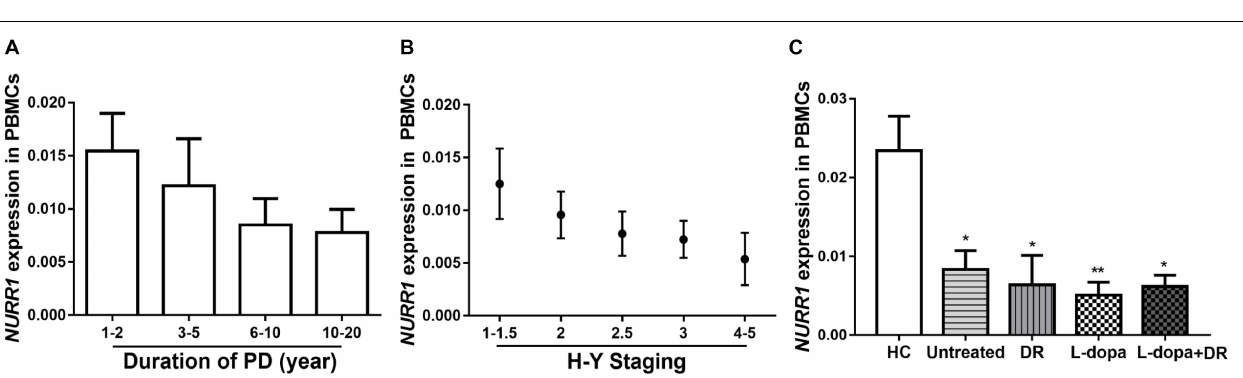
FIGURE 2 | The expression level of NURR1 in PD and HC. The effects of (A) disease course, (B) disease severity, and (C) medication on the expression level of NURR1 in PBMCs. The results are the mean ± SEM values. ∗ p < 0.05 and ∗∗ p < 0.01 relative to HC.